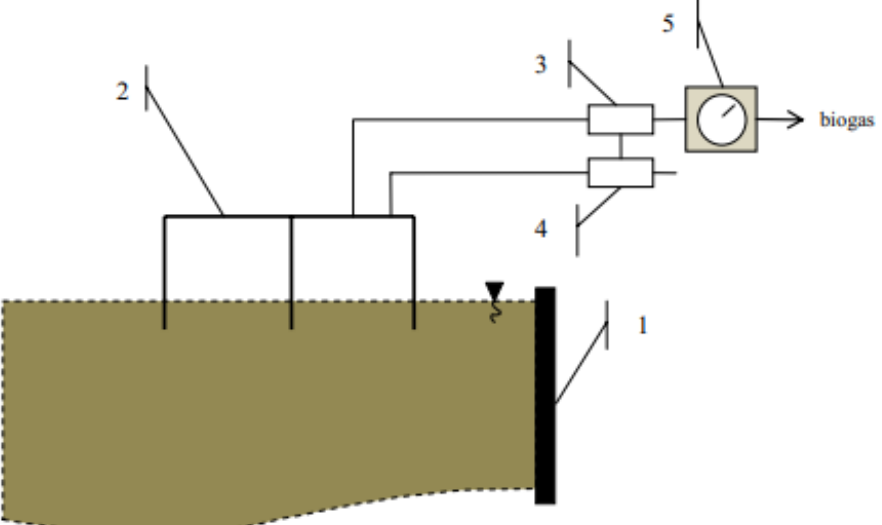
Figure 5. Scheme of biogas gathering: 1—ODC, 2—gas sampler, 3—pump, 4—differential pressure meter, 5—biogas meter [44].